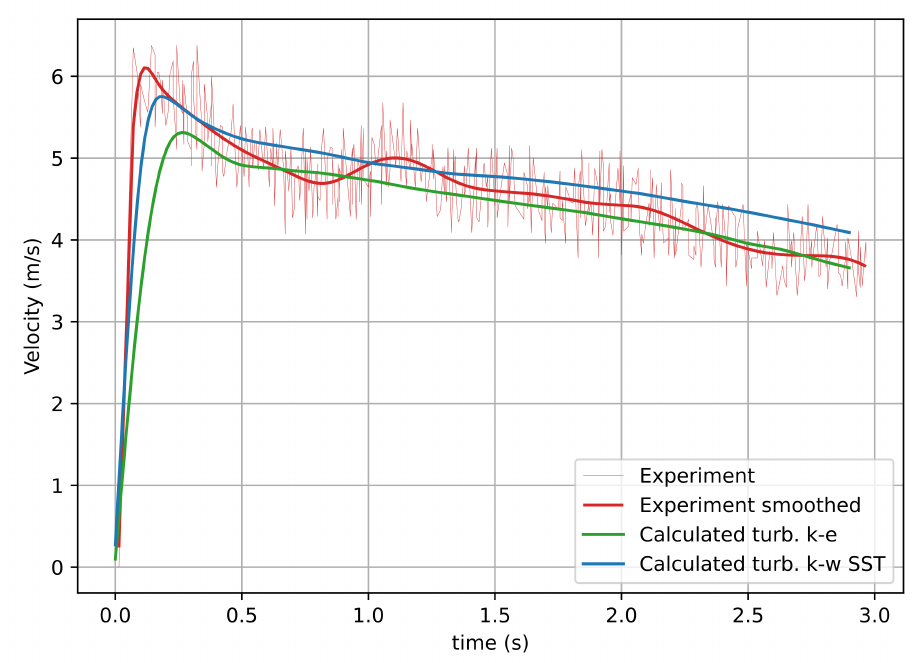
Figure 3. The flow without dams. Depth-averaged velocity at a distance of 11.1 m from the beginning of the chute. Red lines—experiment [38]; green line—simulated by k - ε turbulence model; blue line—simulated by the k - ω SST turbulence